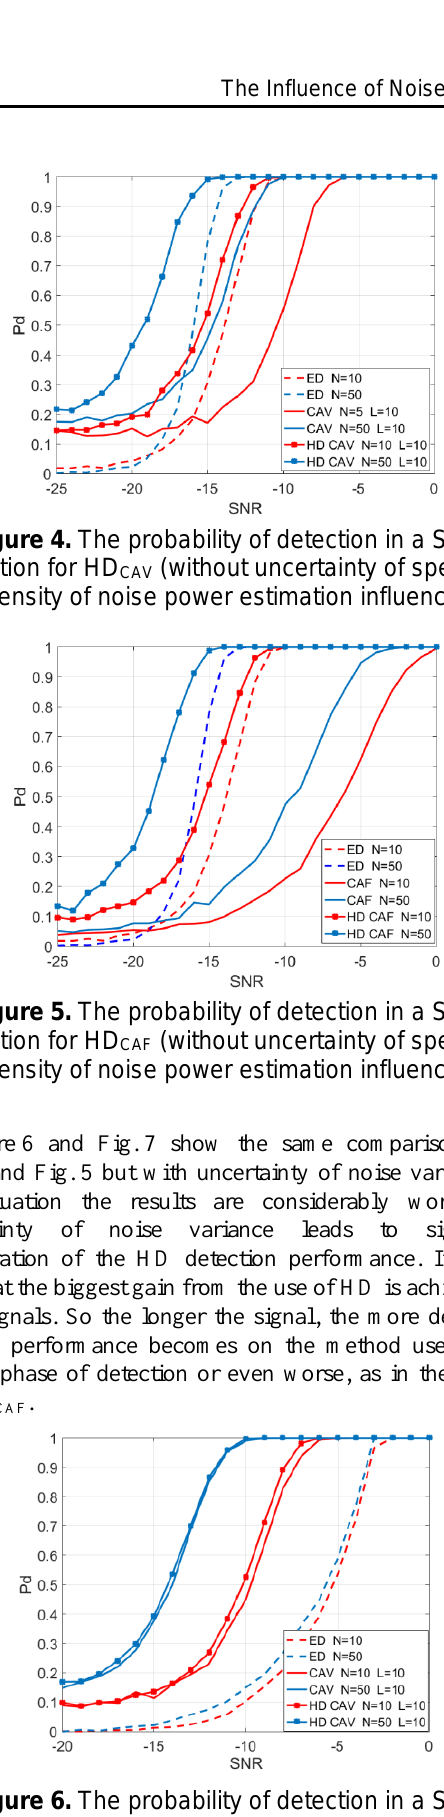
Figure 6. The probability of detection in a SNR function for HD CAV (with uncertainty of spectral density of noise power estimation influence)